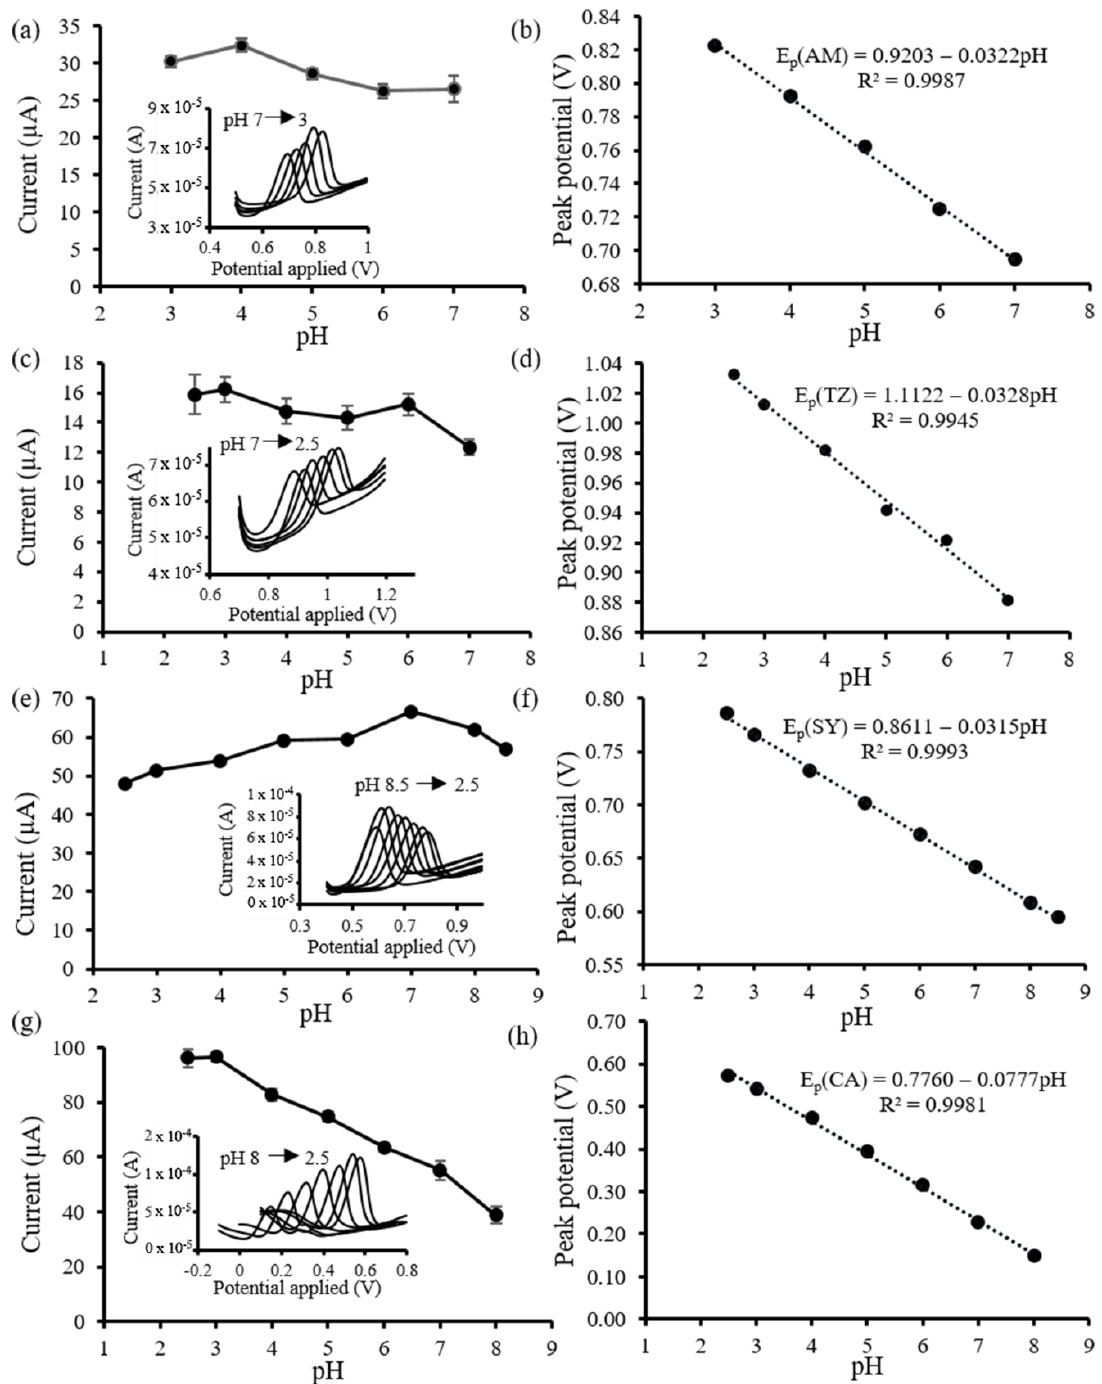
Figure 4. Representation of pH optimization for amaranth ( a ), tartrazine ( c ), sunset yellow ( e ), and carminic acid ( g ). The insets illustrate differential pulse voltammograms at different pH values . The ( b , d , f , h ) represent linear regression between pH and anodic peak potential of amaranth, tartrazine, sunset yellow, and carminic acid, respectively . To achieve the best condition, the pH value of the highest oxidative current response was chosen for further experiments . Thus, acetate buffer pH 4 . 0 was chosen for determi- nation of amaranth, while citrate phosphate buffer pH 3 . 0 was applied for tartrazine and carminic acid . For sunset yellow, the highest current response was obtained from phos- phate buffer pH 7 . 0, therefore it was chosen for determination of sunset yellow .